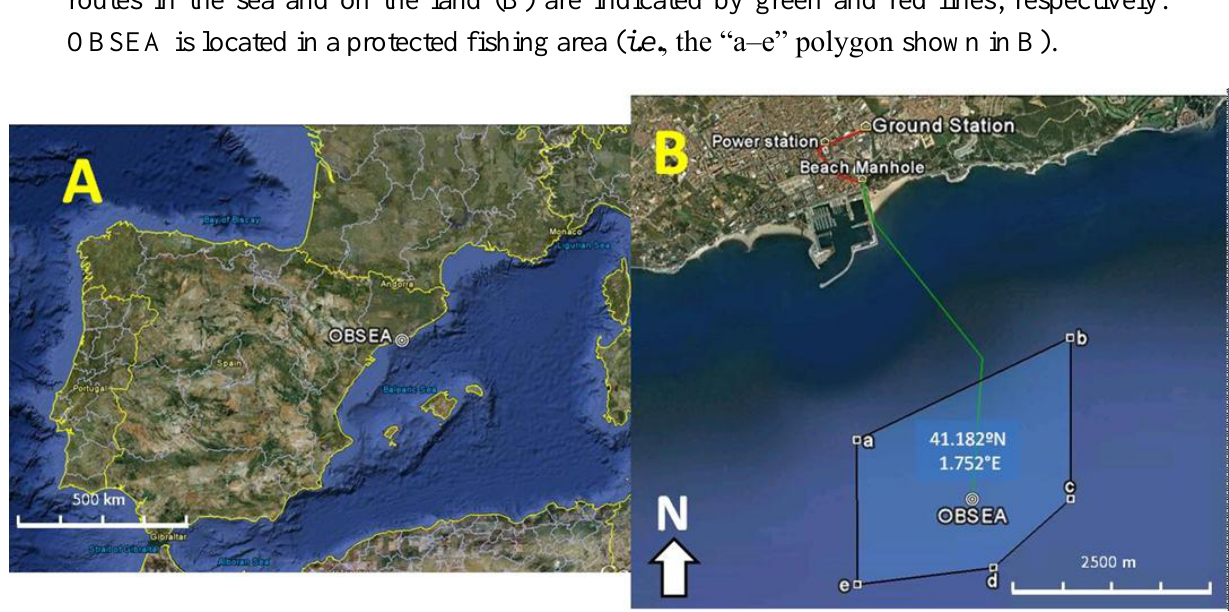
Figure 1. The location of the OBSEA seafloor cabled observatory in the western Mediterranean Sea (A) , with details of its localisation off the Catalan coast (B) . The cable routes in the sea and on the land (B) are indicated by green and red lines,